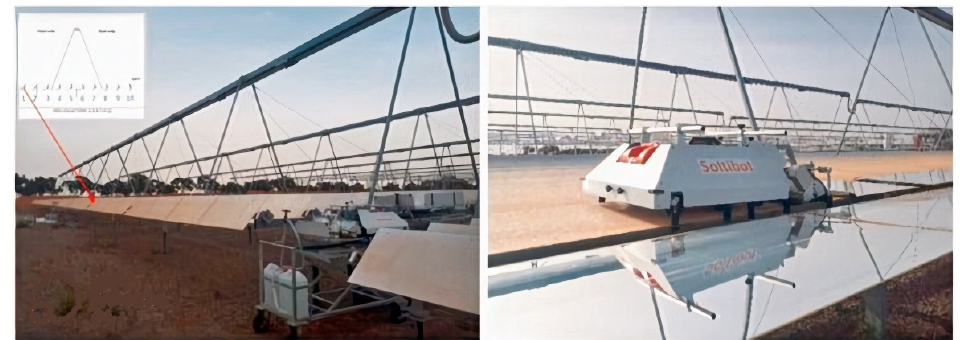
Figure 41. Dirty PV array ( left ) and robotic cleaning ( right ) [164].